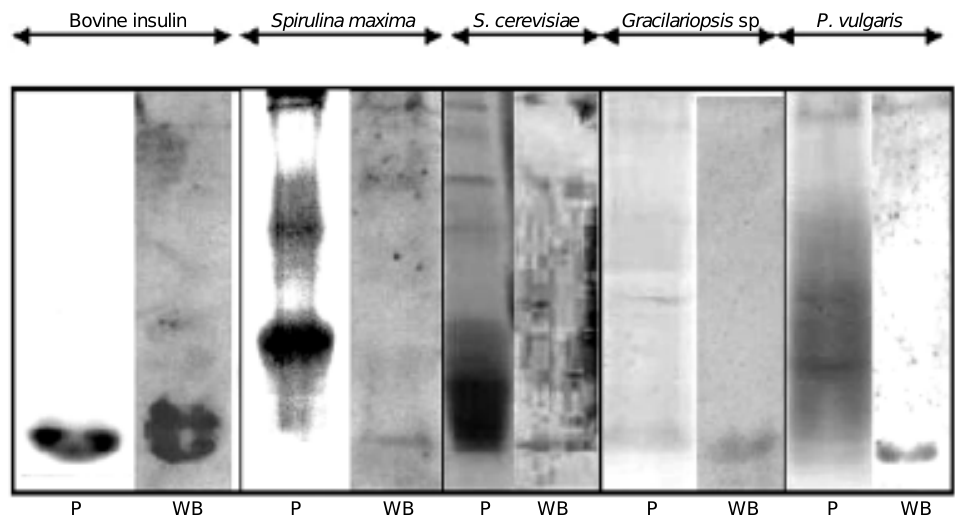
Figure 1. SDS-polyacrylamide gel electrophoresis and Western blotting of extracts from leaves and cells of Phaseolus vulgaris , Gracilariopsis sp, Saccharomy- ces cerevisiae , Spirulina maxi- ma , and bovine insulin. Western blot was done using an anti-hu- man insulin antibody and the re- action was visualized by chemi- luminescence. P, protein (Coo- massie brilliant blue staining); WB, Western